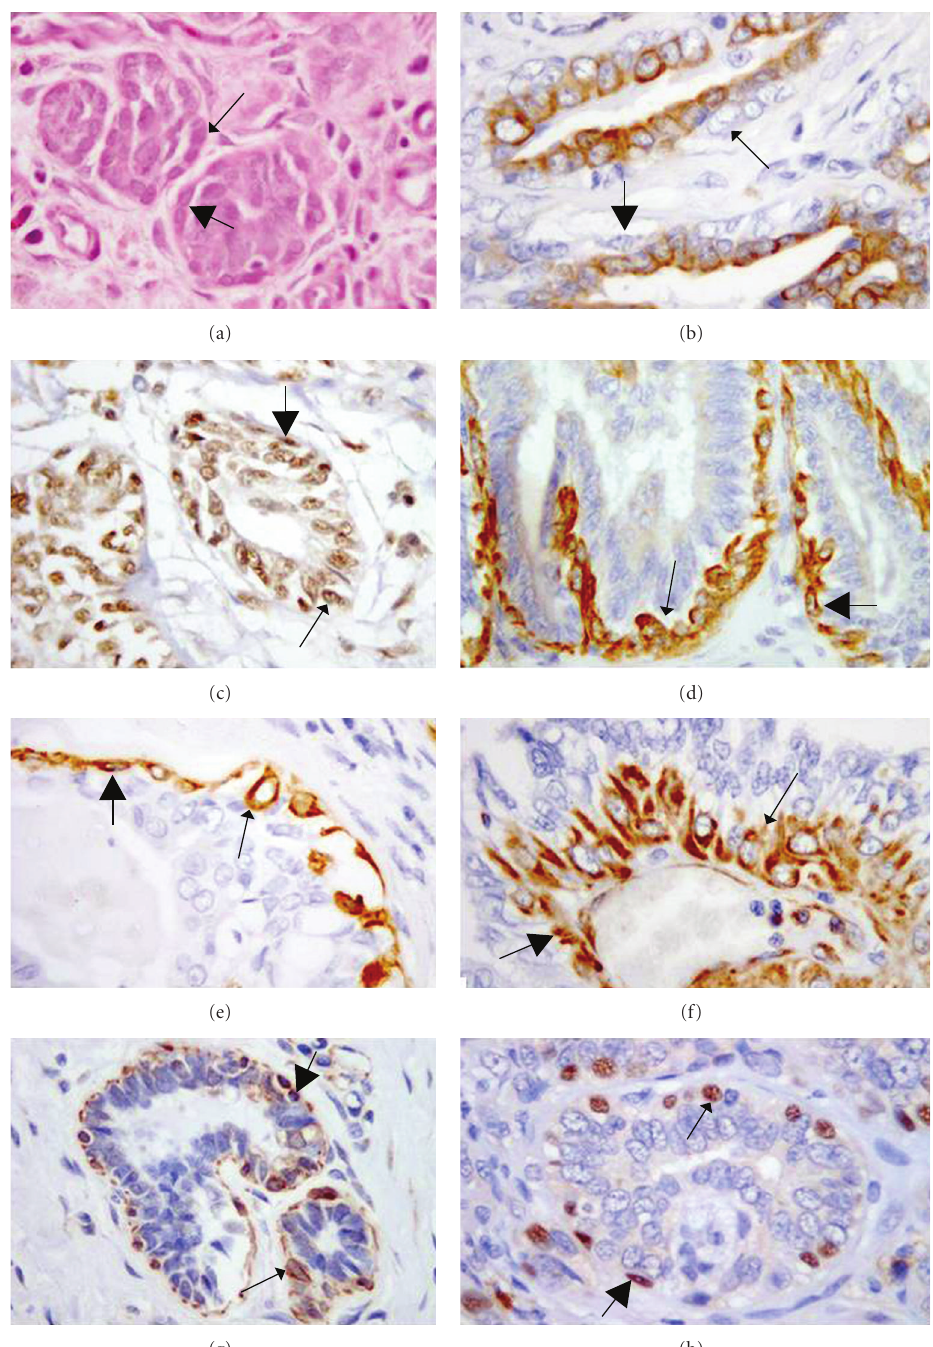
Figure 1: Suprabasal myoepithelial cells: resting (thin arrows) and proliferative (thick arrows) cells. Immunohistochemical expression of a panel of antibodies applied by IHC, 63x (a) Hematoxylin-eosin; (b) anti-CK19 antibodies labeling the cytoplasm; (c) anti-ER antibodies labeling the nuclei; (d) anti-CK 5/6 antibodies labeling the cytoplasm; (e) anti-CK14 antibodies labeling the cytoplasm; (f) anti-VIM antibodies labeling the cytoplasm; (g) anti-Alpha-SMA antibodies labeling the cytoplasmic membrane; (h) anti-p63 antibodies labeling the